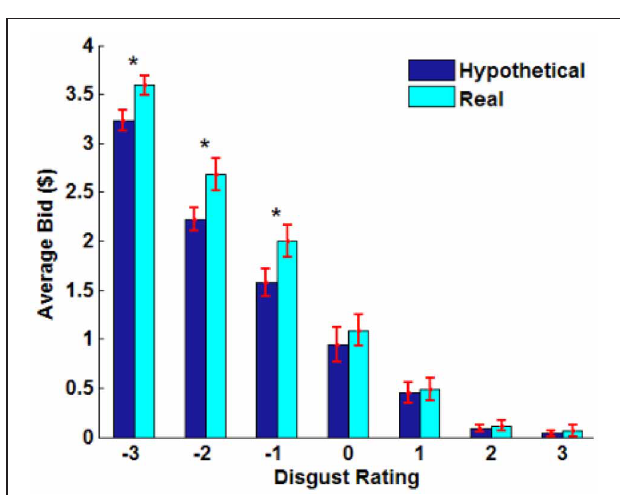
FIGURE A2 | Average bid as a function of average familiarity rating by trial type. Each point represents an individual food item. Solid lines indicate a robust regression line; real bid = − 0 . 34 · familiarity + 2 . 54, hypothetical bid = − 0 . 38 · familiarity + 2 . 29 (all coefficients significant at p < 0 . 05).